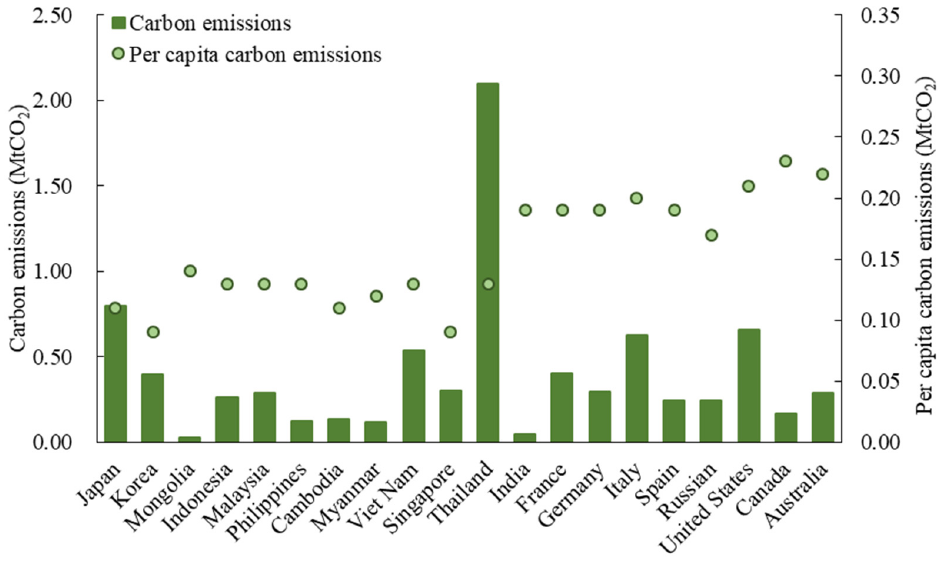
Figure 4. The sending system carbon emissions of China’s outbound tourism in 2015 (20 main countries are shown).